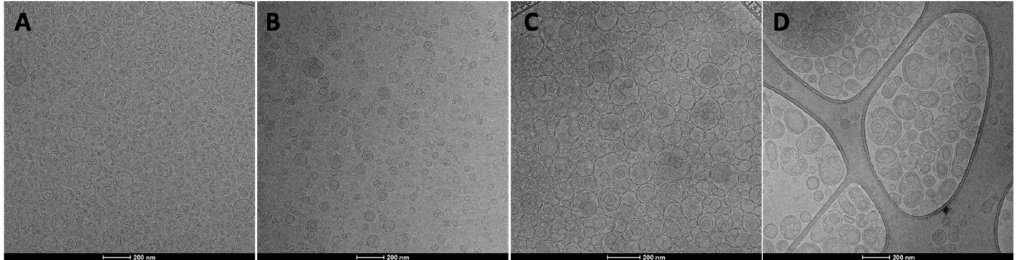
Figure 2. Representative cryo-TEM images of transfersomes ( A ), glycerosomes ( B ), hyalurosomes ( C ) and glycerohyalurosomes ( D